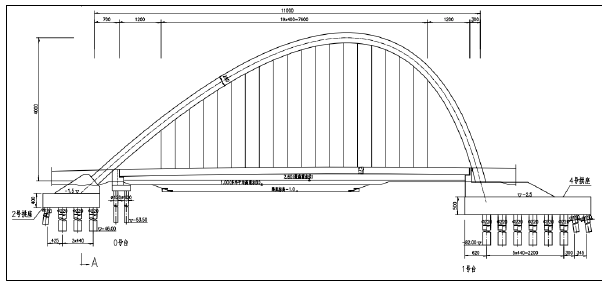
Figure 2. The elevation of arch rib No. 2.